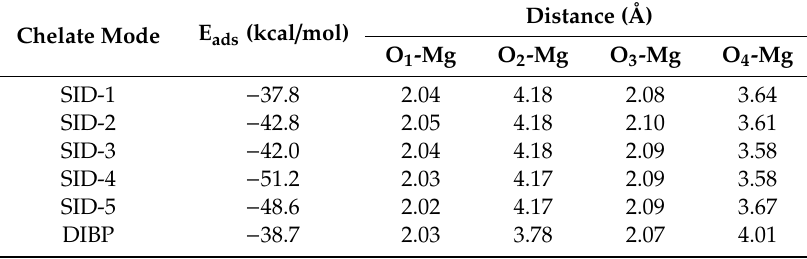
Table 3. Adsorption energies (E ads ) and O-Mg distances of the five salicylate donors (SID-1–SID-5) and diisobutyl phthalate (DIBP) adsorbed on the pre-activated MgCl 2 (110) surface with the preferred chelate